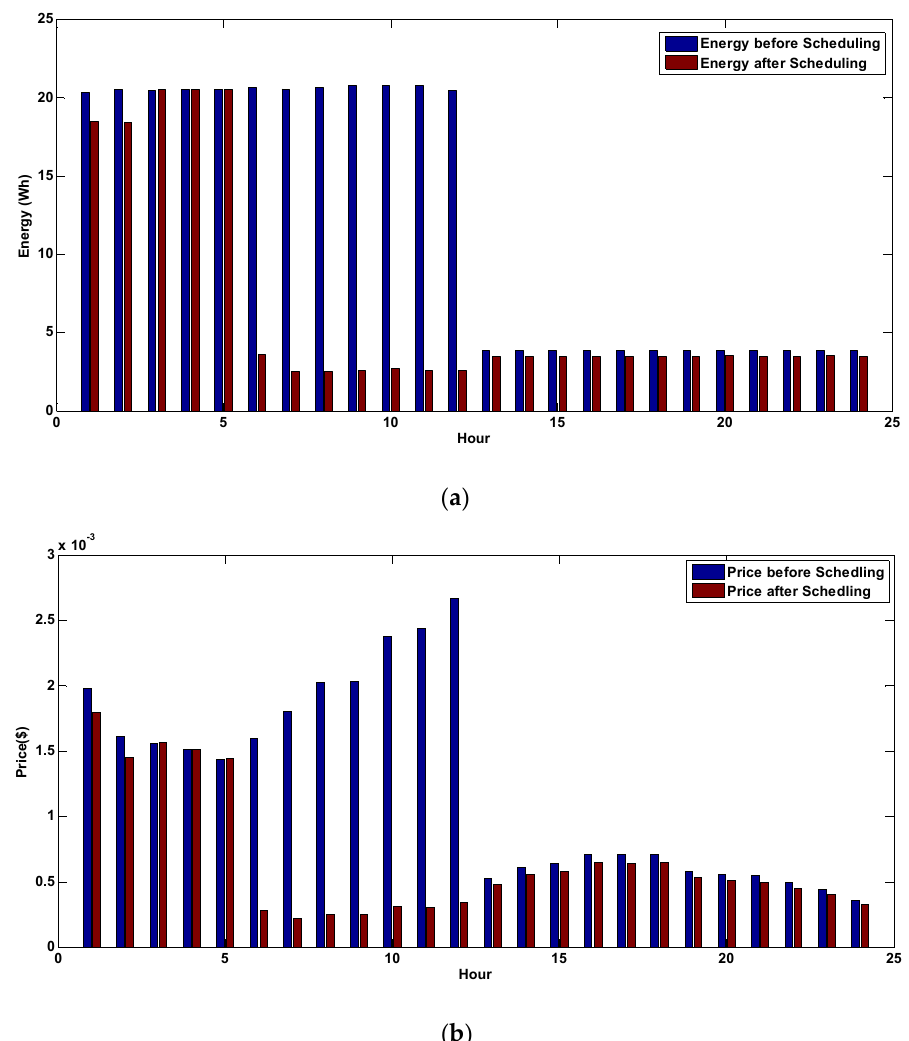
Figure 18. ( a ) Energy consumptions and ( b ) bills incurred by the LED light without and with the use of the HEM system.